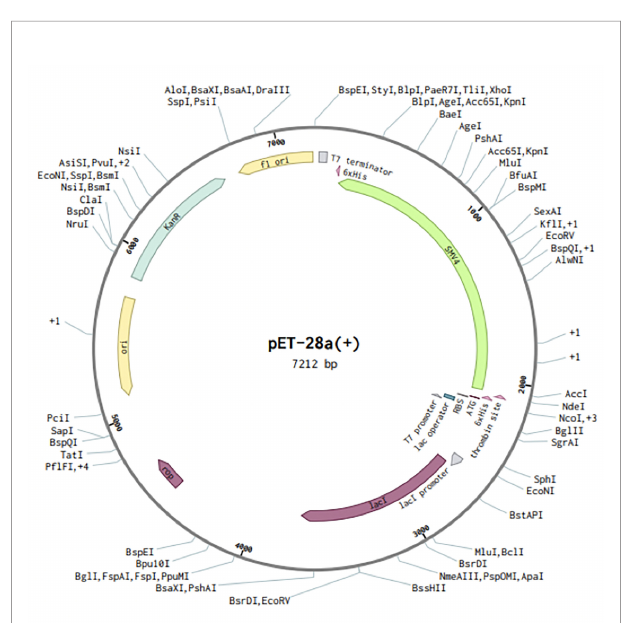
FIGURE 9 | In silico restriction cloning of the multi-epitope vaccine sequence (SMV4) into the pET28a (+) expression vector. Green arrow represents the vaccine ’ s gene coding. The His-tag is located at the N-terminal